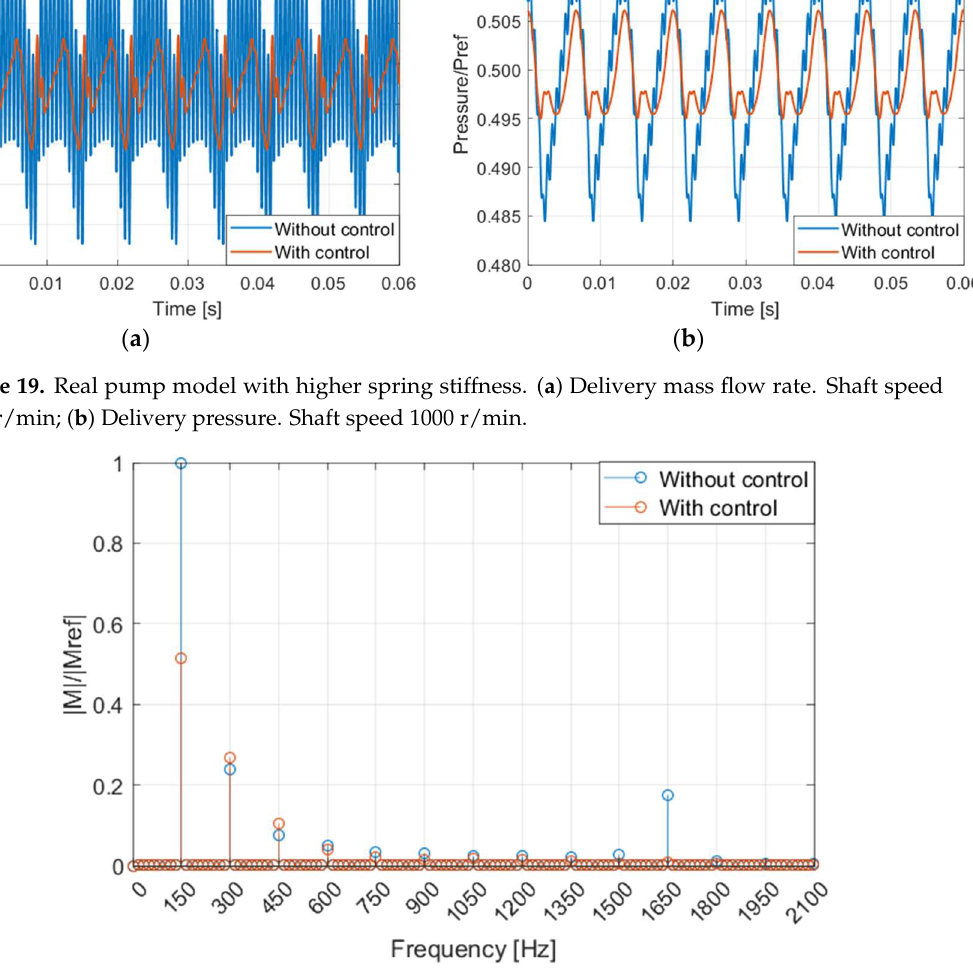
Figure 20. Real pump model with higher spring stiffness. Delivery pressure FFT. Shaft speed 1000 r/min.